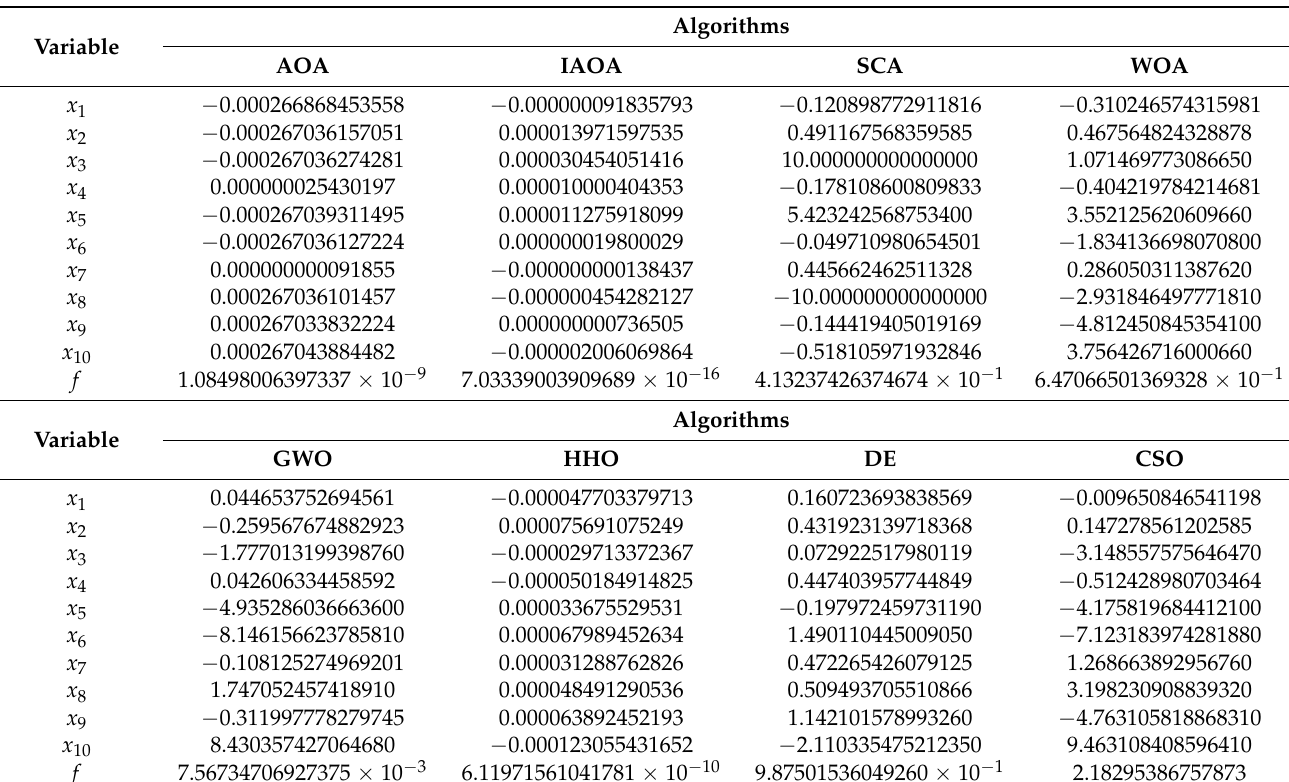
Table 4. Comparison of the experimental results for